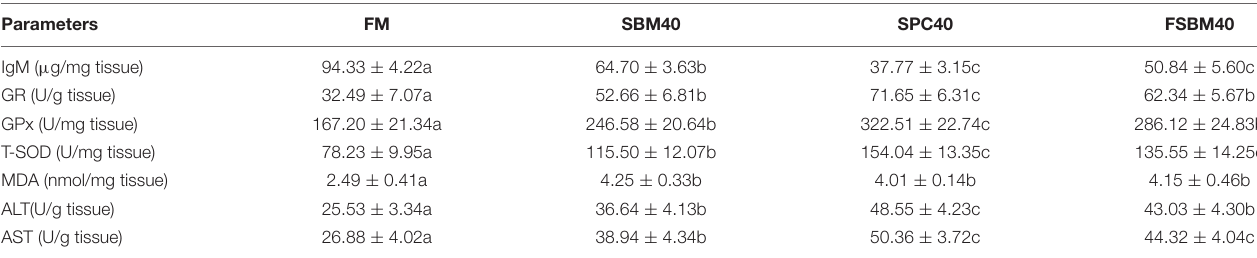
protein concentrate (SPC) protein substitute for FM protein; FSBM40, 40% fermented soybean meal (FSBM) protein substitute for FM protein. Different letters assigned to the lines represented significantly differences between the groups at P <